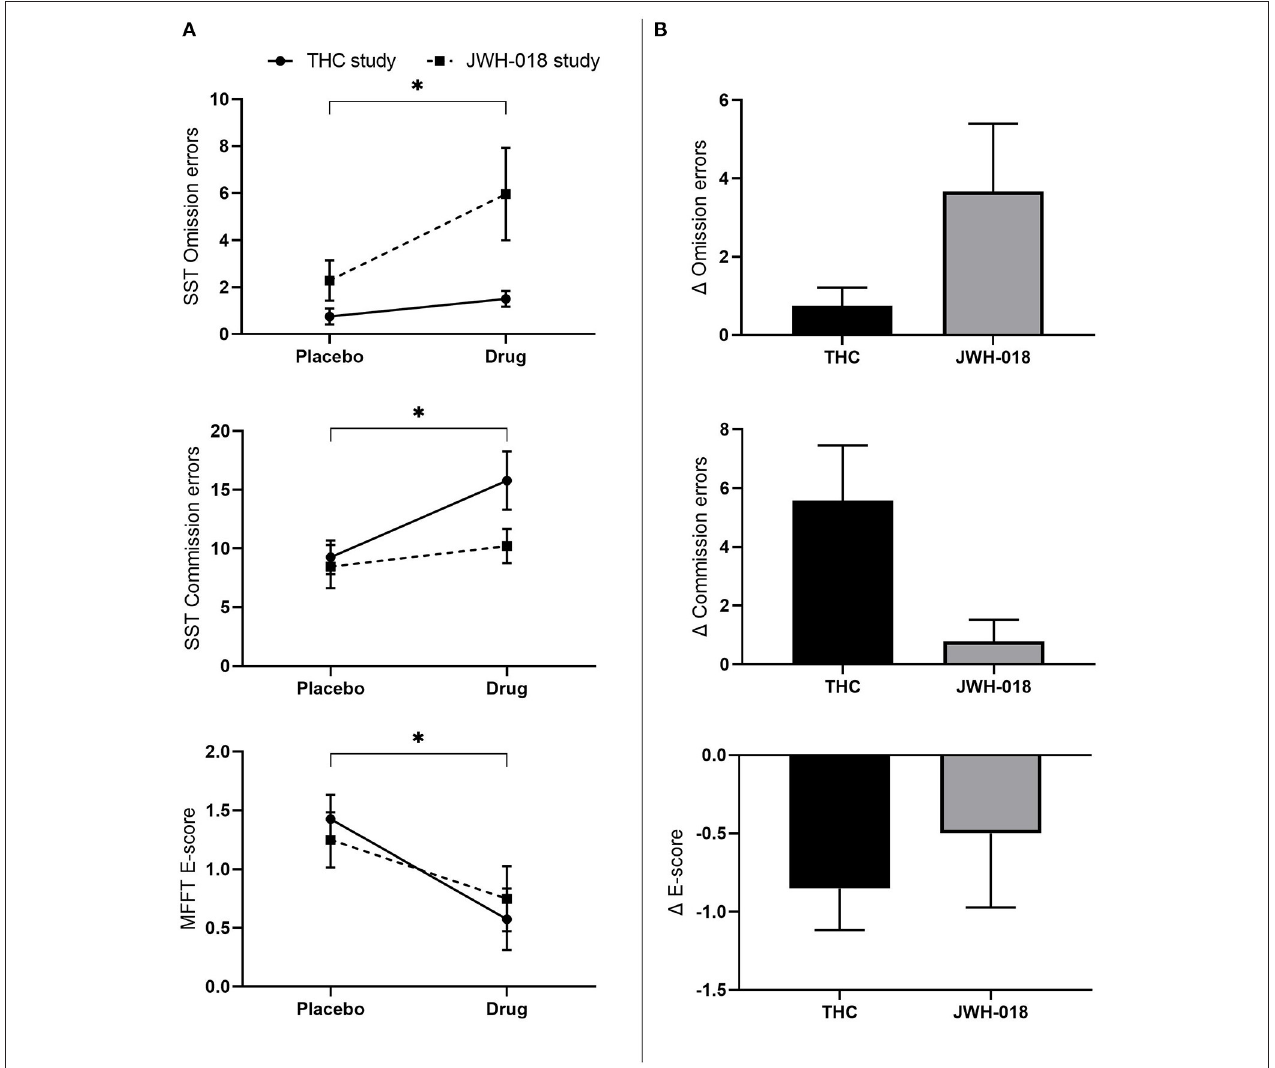
FIGURE 4 | (A) Mean (SEM) number of omission and commission errors in the stop signal task and E-score in the matching familiar figures test for placebo and drug conditions, in the THC and JWH-018 study. *Significant difference between the active condition (THC/JWH-018) and placebo. (B) E-score in the matching familiar figures test for both drug conditions shown as difference scores (relative to